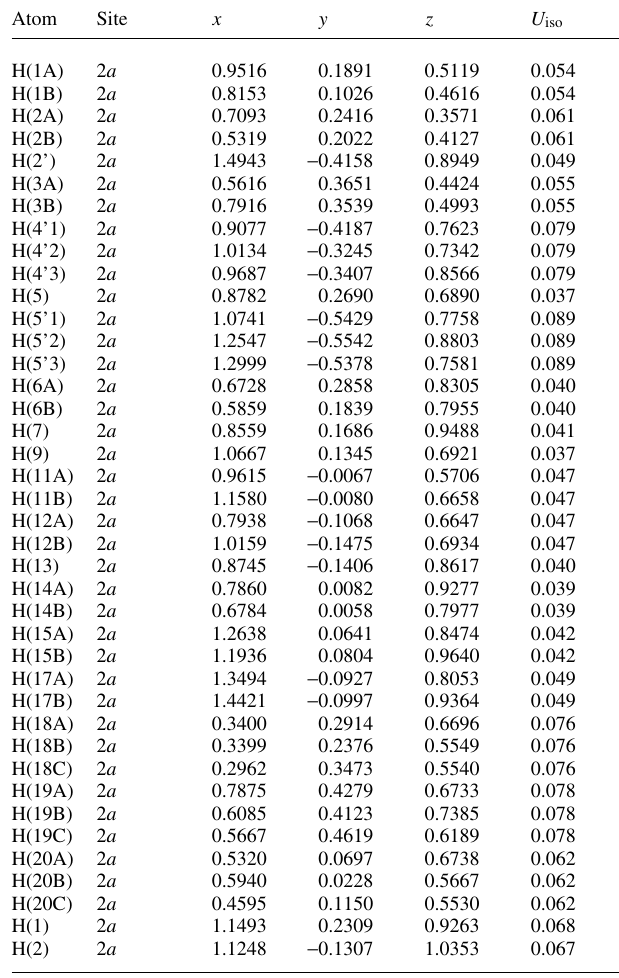
Table 2. Atomic coordinates and displacement parameters (in Å 2 )